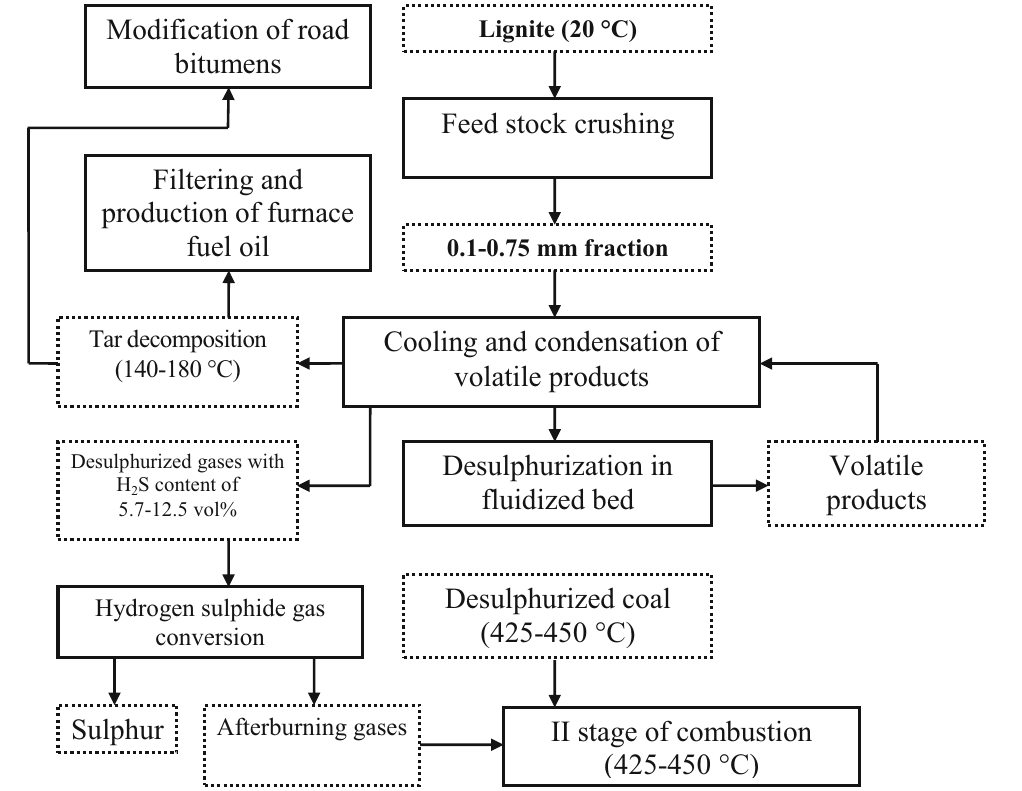
Fig. 1 Block schematic diagram of the oxidative desulphurization of